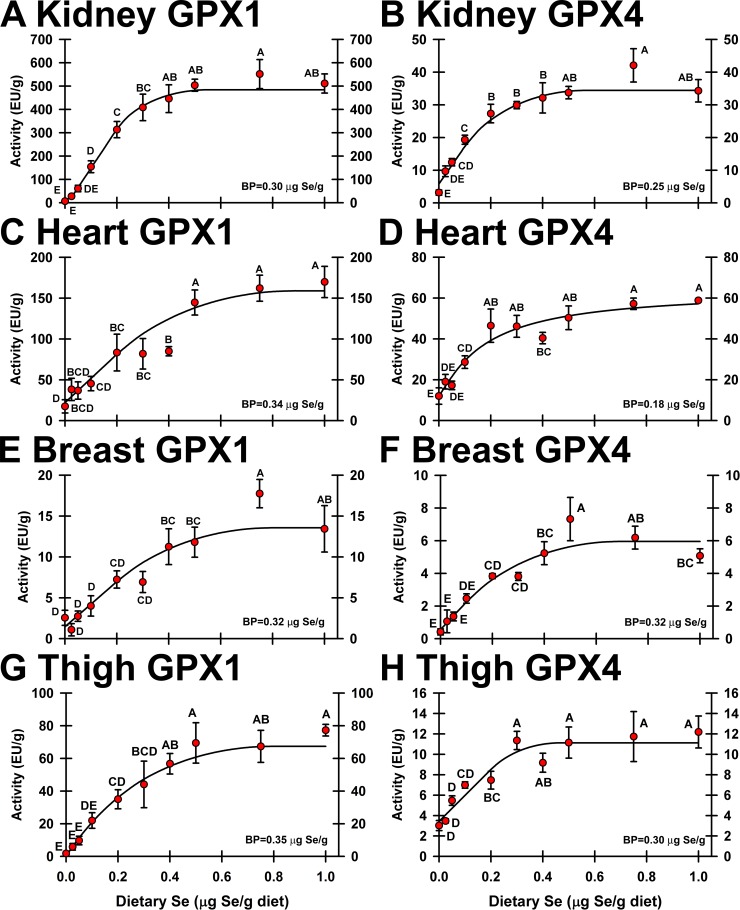
Effect of dietary Se on GPX activity.GPX1 and GPX4 activity in kidney (A, B), heart (C, D), breast (E, F) and thigh (G, H). Values are the means ± SEM (n = 5/treatment). Means without a common letter are significantly different (p<0.05). Overall levels of significance, as determined by ANOVA, are given in Table 1. Se response curve breakpoints (BP) are calculated as described in text.